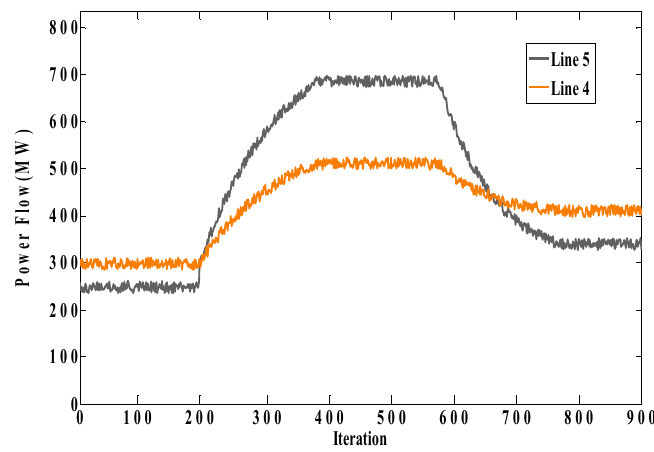
Figure 10. Power flows of Lines 4 and 5 in Case A.